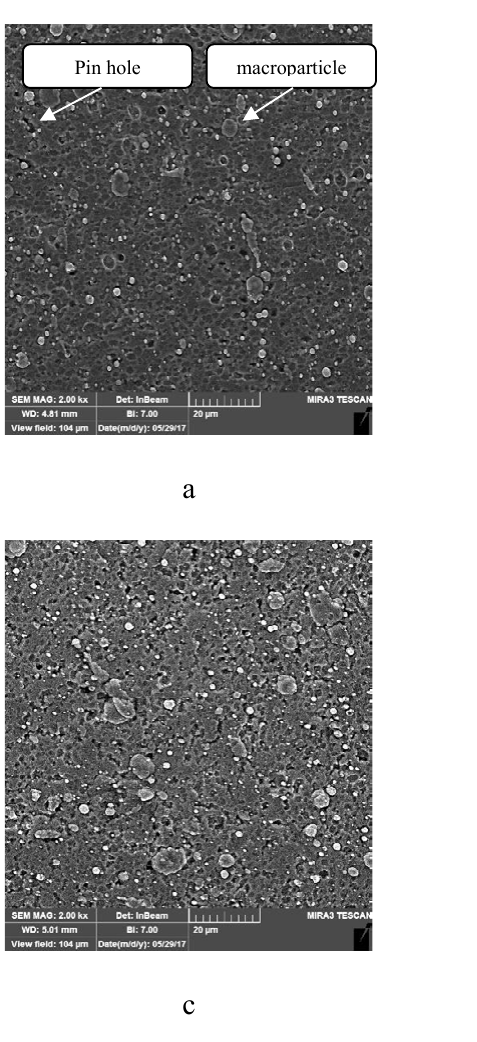
Fig. 3. Surface FESEM images of samples. a)TiN, b)CrN, c)TiN/CrN, d)Bare